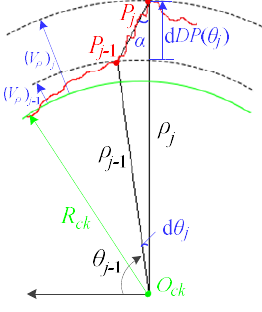
Figure 8. Break between point P j − 1 and P j in polar coordinate system, in which O ck denotes the pole, ρ and θ denote polar coordinates, R ck is radius of the fitted circle, V ρ is radial distance between contour point and the fitted circle, d DP and d θ j are radial and angular di ff erence between the two points, and α is the angle between line P j − 1 P j and radial direction at point P j . The LTBC algorithm is designed for (cid:1848) (cid:3096) correction to points in mutations according to the linear trends of adjacent (cid:1845)(cid:1872)(cid:1857)(cid:1868) (cid:2868) sequences. In Figure 9, magenta and green solid lines denote detected I- Mutation to be corrected, and the blue lines denote the last and next (cid:1845)(cid:1872)(cid:1857)(cid:1868) (cid:2868) sequence. As shown in